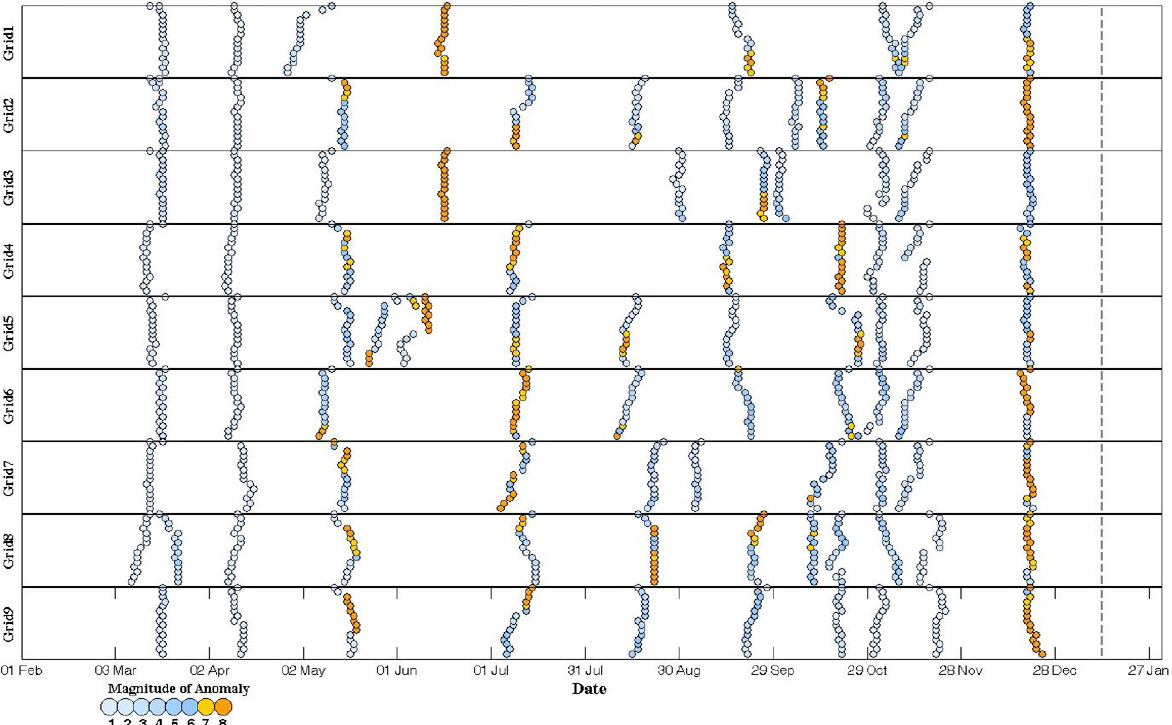
Fig. 4. Wavelet maxima analysis curves from Grid1 to Grid9, with a set of grids of 3 × 3degree of latitude by longitude area over the epicenter, the dashed line indicates the day when the earthquake occurred.